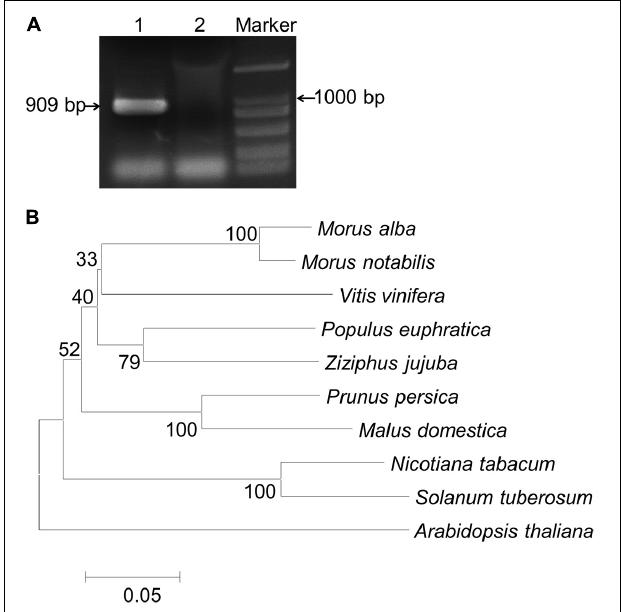
FIGURE 1 | PCR products of MaCDSP32 and neighbor-joining phylogenetic analysis. (A) PCR amplification products of MaCDSP32 . Lane 1: products of MaCDSP32; Lane 2: negative control (distilled water) used as a template for PCR. (B) A phylogenetic tree of the amino acid sequences of CDSP32 proteins from Rosales and several typical plant species was constructed using the MEGA 6.0